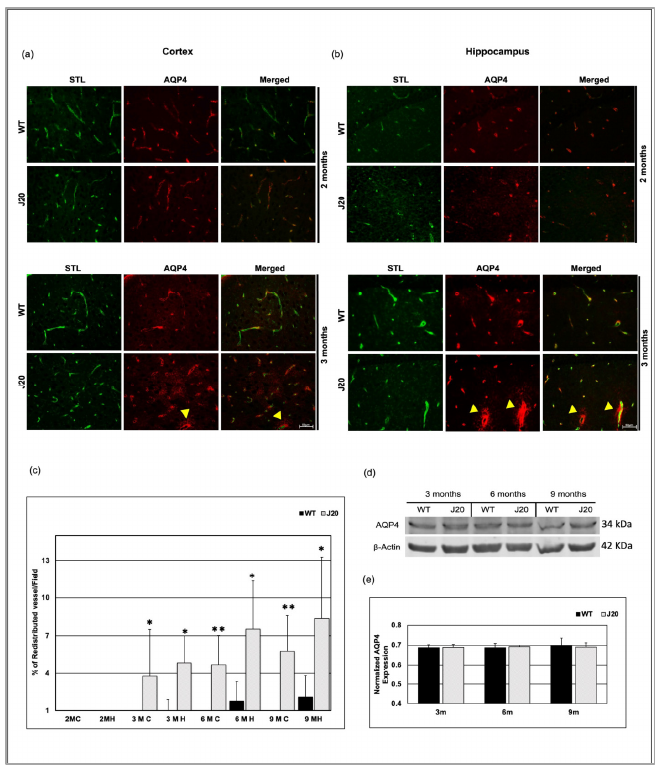
Figure 7. AQP4 redistribution in J20 mice brains. Immunofluorescence for the lectin, STL (green), and AQP4 (red) was shown in the cortex ( a ) and hippocampus ( b ) of WT and J20 brains at 2 and 3 months of age. At 2 months, STL/AQP4 uniform colocalization (around the vessel) was observed in the WT and J20 brain. At 3 months, intense expression of AQP4 outside the vessel in the parenchyma (redistribution) in J20 mice (indicated by yellow arrowhead). ( c ) Percentage of redistributed vessel/field in the cortex and the hippocampus of both WT and J20 mice brain at 2, 3, 6, and 9 months of age. ( d ) Representative immunoblot of AQP4 protein expression in the hippocampus of WT and J20 mice brains at 3, 6, and 9 months of age. ( e ) Normalized hippocampal AQP4 expression of different groups at 3, 6, and 9 months. Numerical data are presented here as average ± SD, and statistical significance is denoted as * p < 0.05, ** p < 0.01 vs. age-matched WT. C = cortex and H = hippocampus. M indicates month. Scale bar = 50 µm.